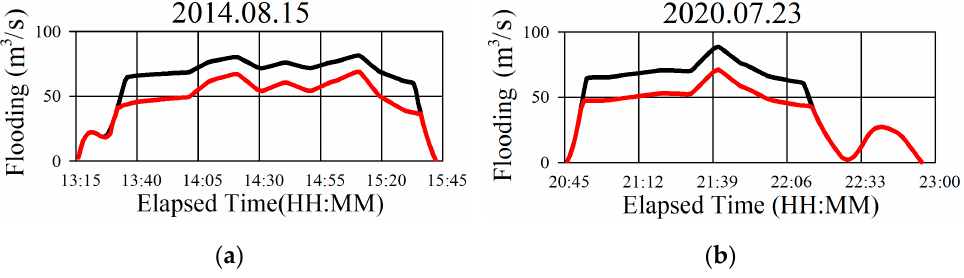
Figure 13. Flooding on the Oncheon River before and after installing underground waterway (actual rainfall). ( a ) 2014.08.15; ( b ) 2020.07.23.